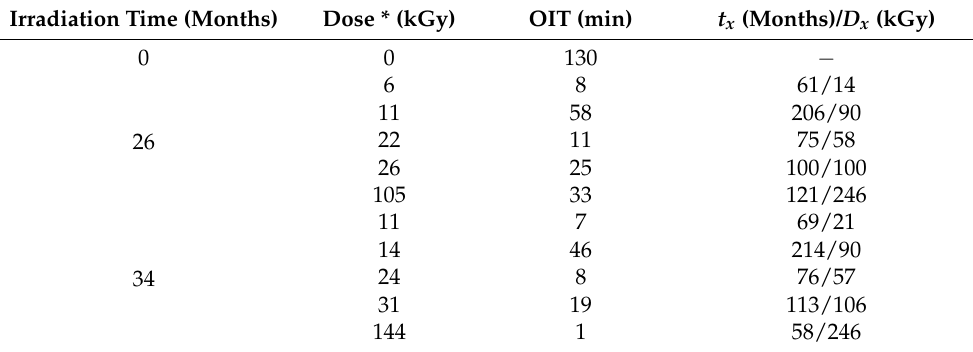
Figure 10. Exponential OIT decrease during irradiation in the CERN—SPS accelerator. ( a ) OIT vs. irradiation time; ( b ) OIT vs. irradiation dose. Table 4. Degradation model parameters and lifetime evaluation of EVA sheath of a multiconductor Figure